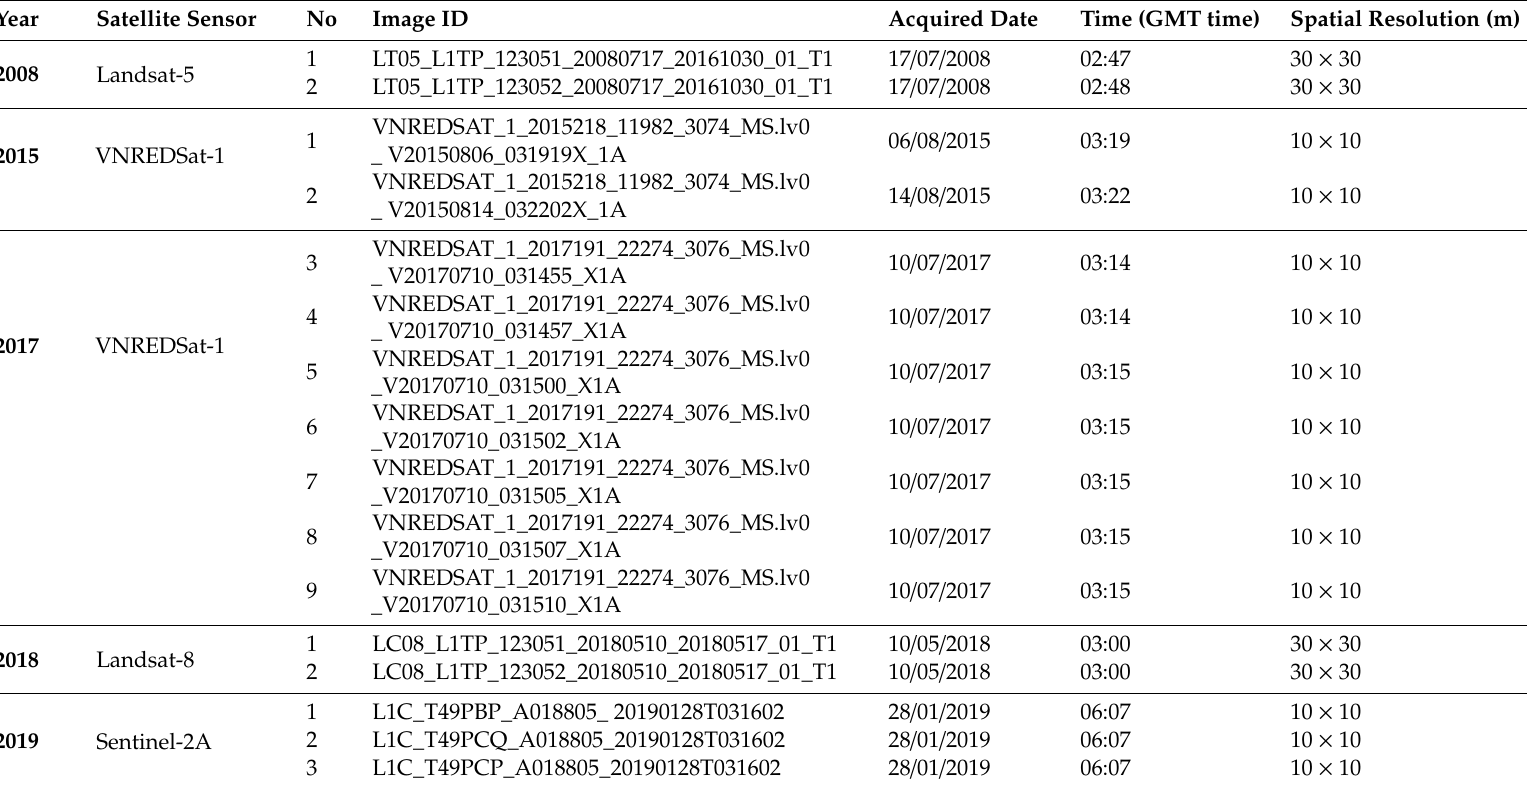
Table 2. Satellite image data used for SAV mapping and changes